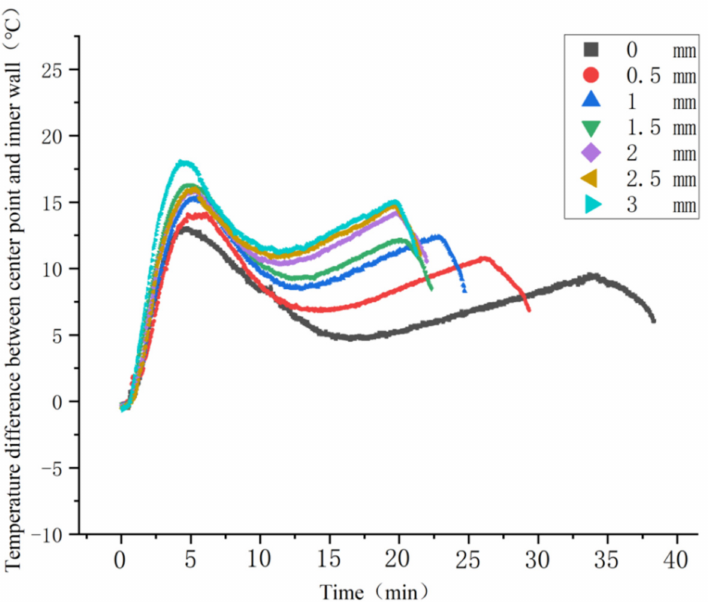
Figure 11. Temperature difference between the center point and the inner wall changes with